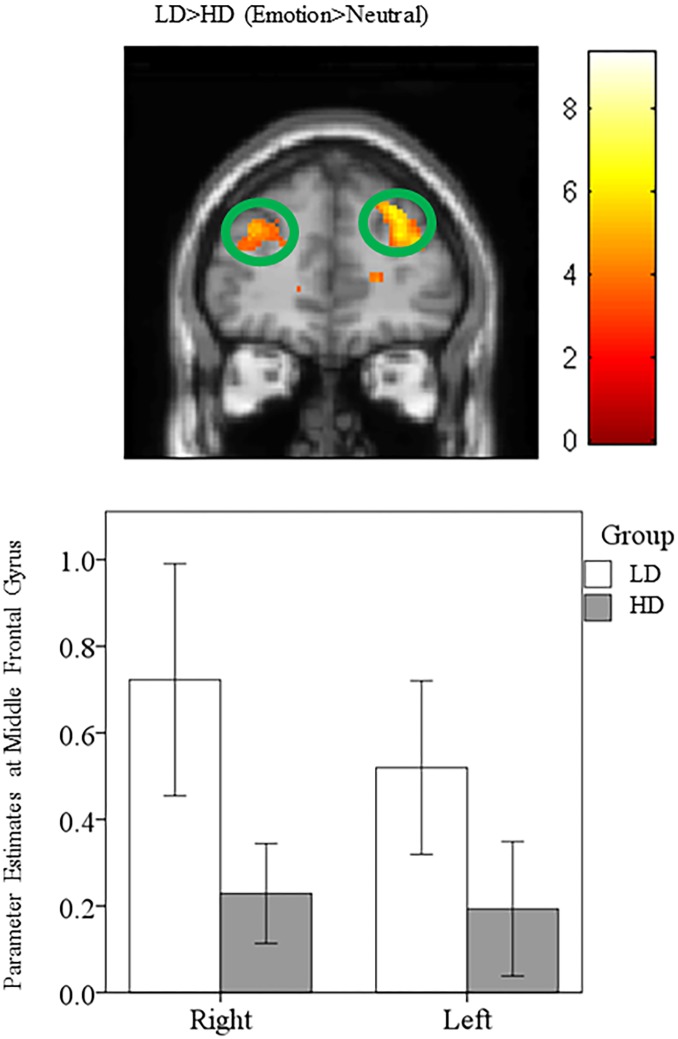
Statistical parametric maps for middle frontal gyrus.Post-hoc independent sample t-tests using whole brain analysis revealed heightened response in the bilateral middle frontal gyrus for the LD>HD (Emotion>Neutral) comparison. For illustration purposes the comparison is displayed at p<0.001 uncorrected, but the clusters in the circles are corrected for multiple comparisons (p<0.025 FWE). Note the peak voxel for the left middle frontal gyrus is slightly posterior to the circled area of activation.